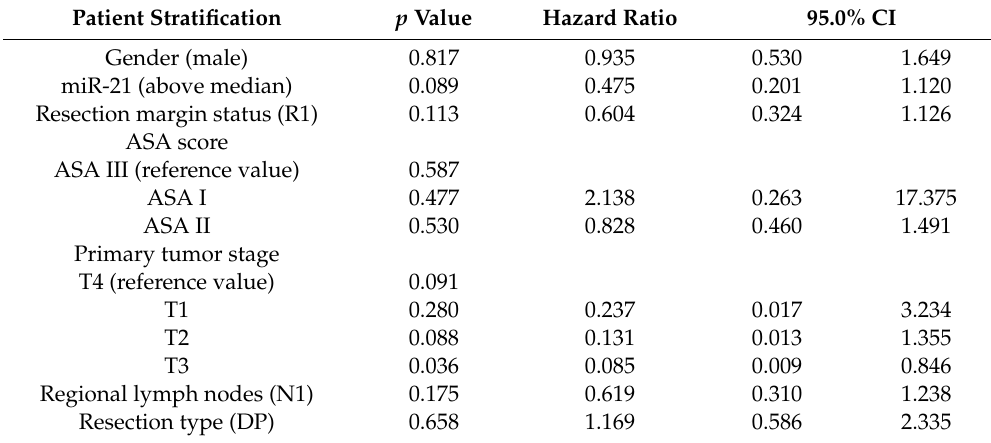
Table 4. Results of multivariate analysis (Cox’s proportional hazards model) of the e ff ects of clinical and pathological characteristics and miR-21 expression on patients’